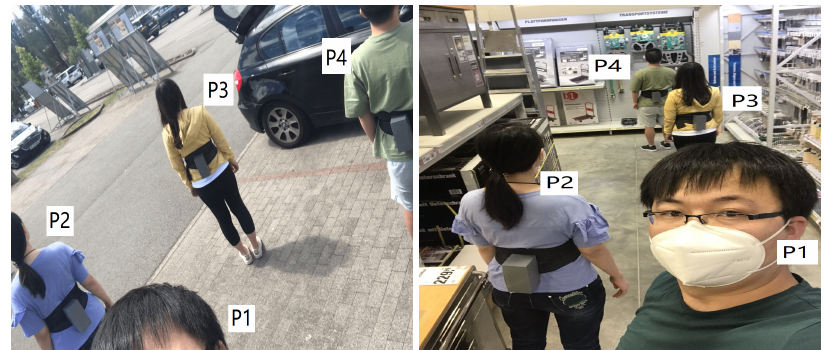
Figure 19. Four volunteers’ practical test outside and inside the construction material supermarket where a more complex environment exists. P1 and P2 as one group with a distance of 1.0 m and P3 and P4 as